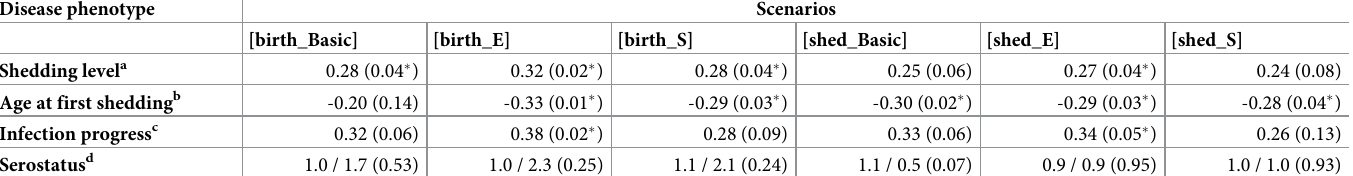
Table 2. Association between number of recipients of an individual cow and her disease phenotype, by scenario. For phenotypes “shedding level”, “age at first shed- ding” and “infection progress”, Spearman’s rank correlation coefficients and ( p values) are presented. For “serostatus”, mean number of recipients for both phenotype lev- els and ( p values) of Welch’s two sample t test are presented (n = 57 cows). Disease